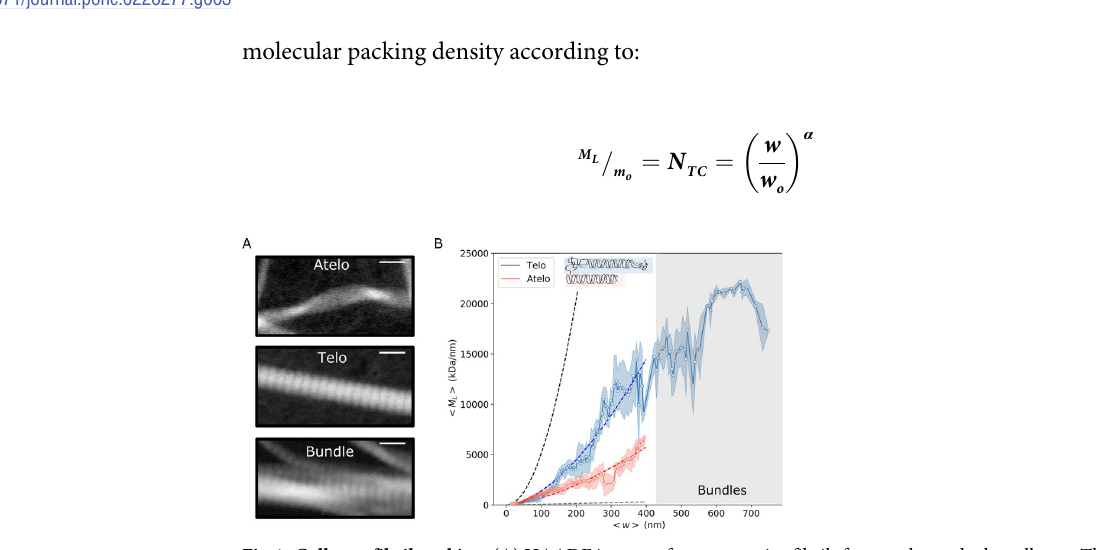
Fig 3. Mass mapping of bovine type I collagen fibrils. (A-B) Images of reconstituted atelocollagen fibrils adsorbed on an electron microscope grid. Images of the same sample were acquired using (A) HAADF mode with STEM, and (B) AFM contact mode in air (height color coded from 0 to 55 nm). Scale bar 500 nm. (C) Sketch of the different morphological features encountered in collagen fibrils, as seen in (A-B). (D-E) Distribution of the fibril width w (D) and M the image shown in (A). n = 5000 segments.